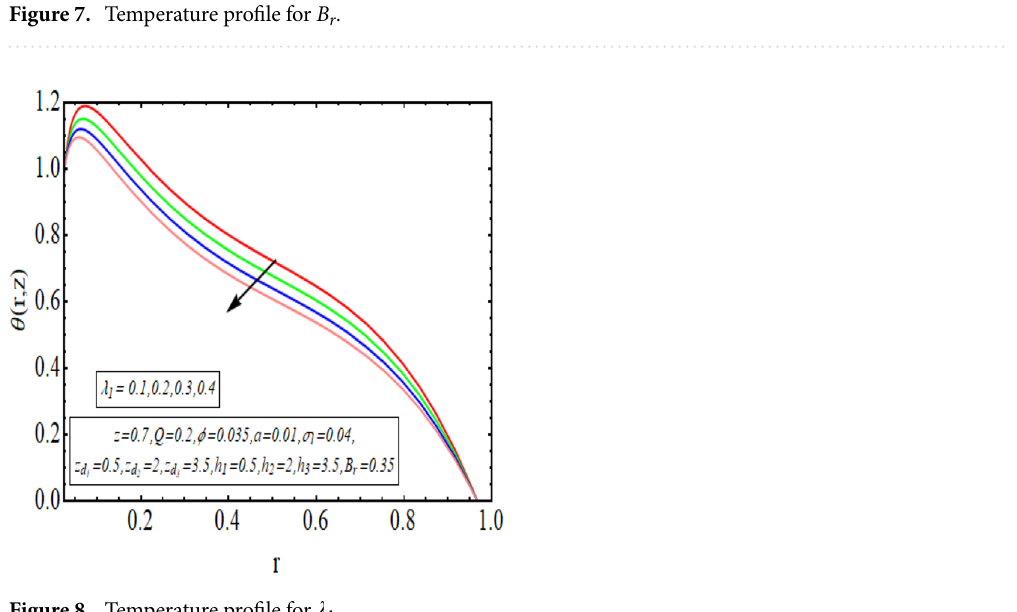
Figure 8. Temperature profile for (cid:31) 1